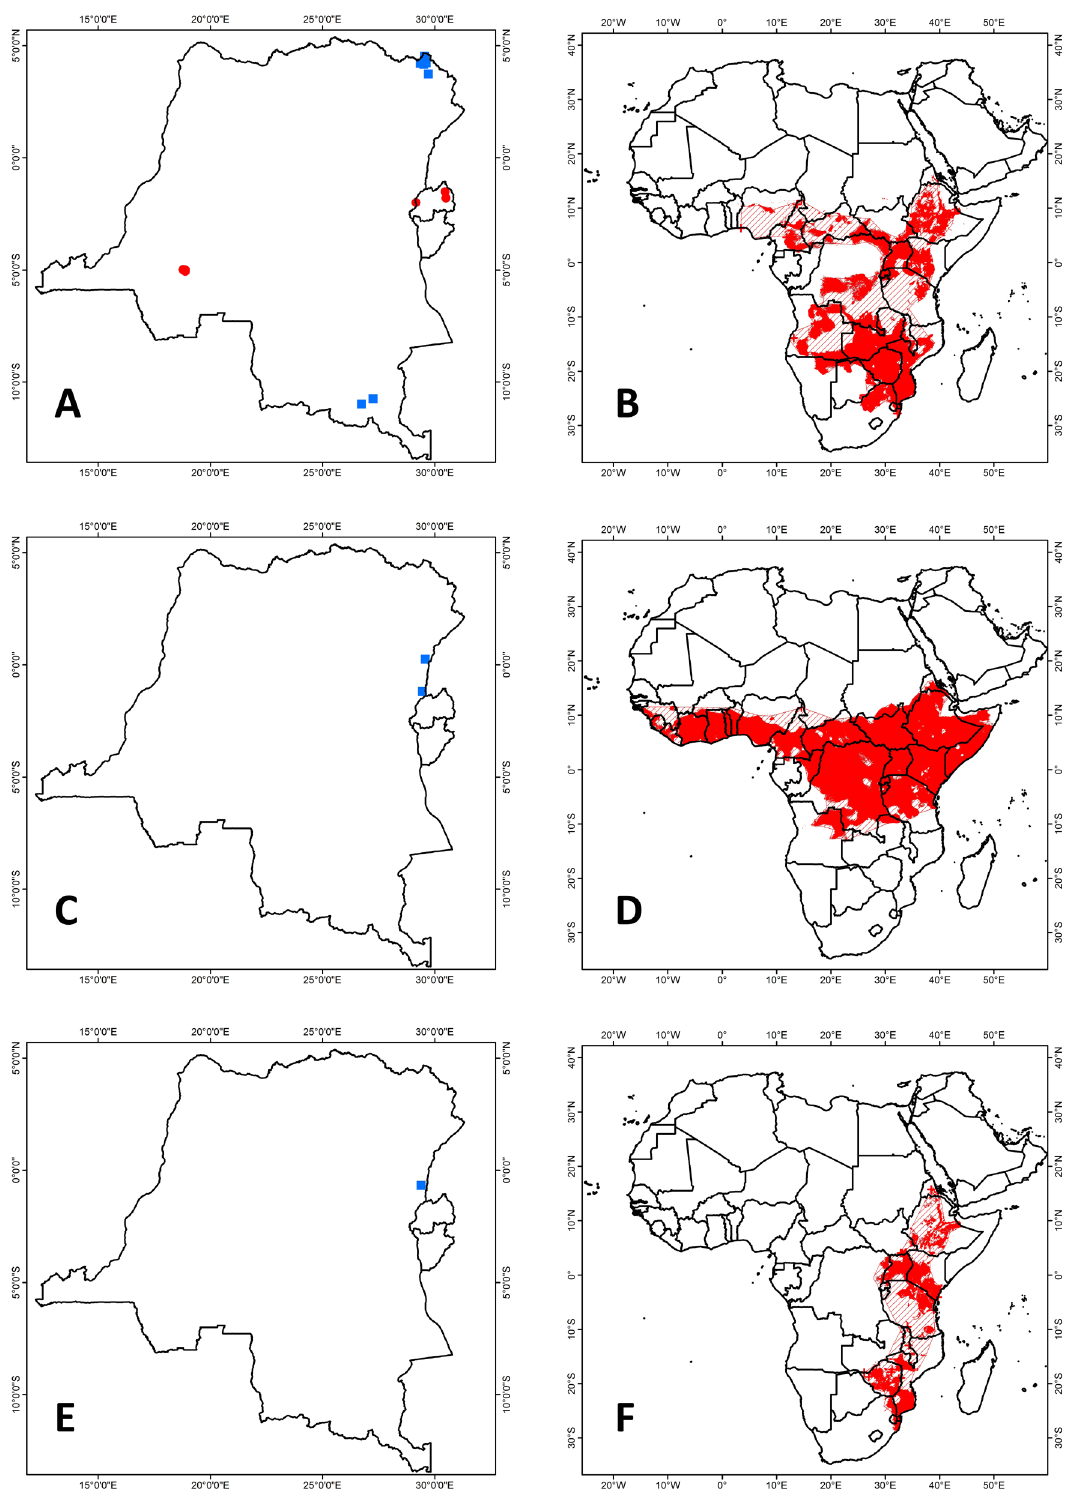
Fig. 24. Distribution maps. A–B . Chaerephon ansorgei (Thomas, 1913). C–D . Chaerephon